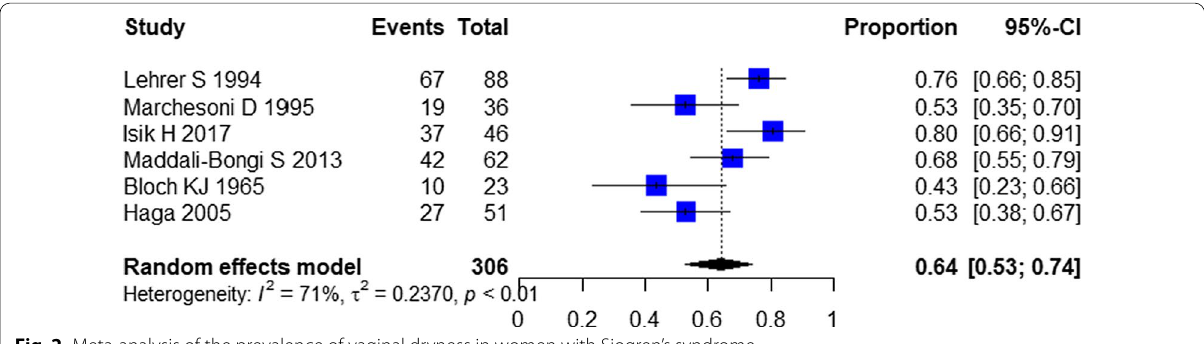
Fig. 2 Meta‑analysis of the prevalence of vaginal dryness in women with Sjogren’s